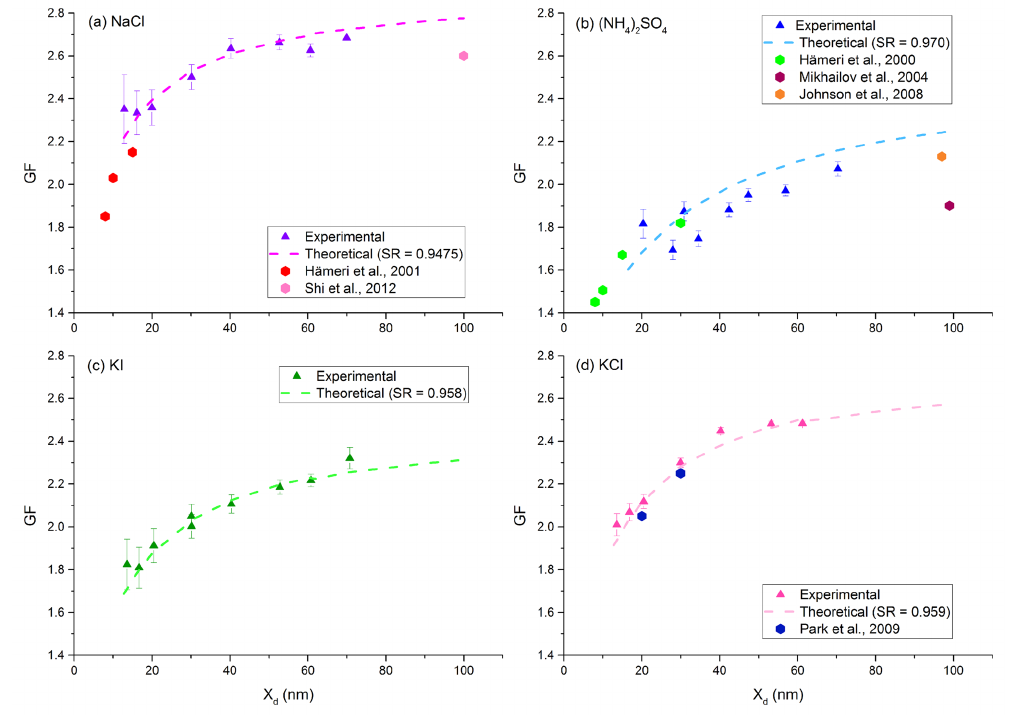
Figure 2. Growth factor as a function of dry particle diameter ( X d ) for NaCl (a) , (NH 4 ) 2 SO 4 (b) , KI (c) , and KCl (d) .